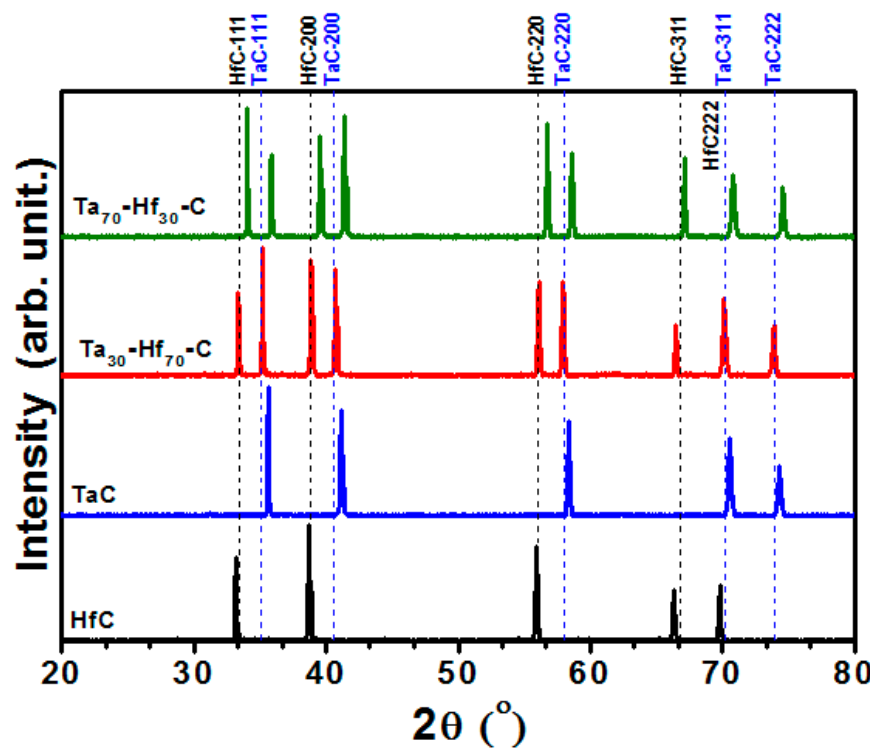
Figure 2. Diffraction pattern of the TaC and HfC individual coatings and the (Ta 30 -Hf 70 -C) and (Ta 70 -Hf 30 -C) system composed.